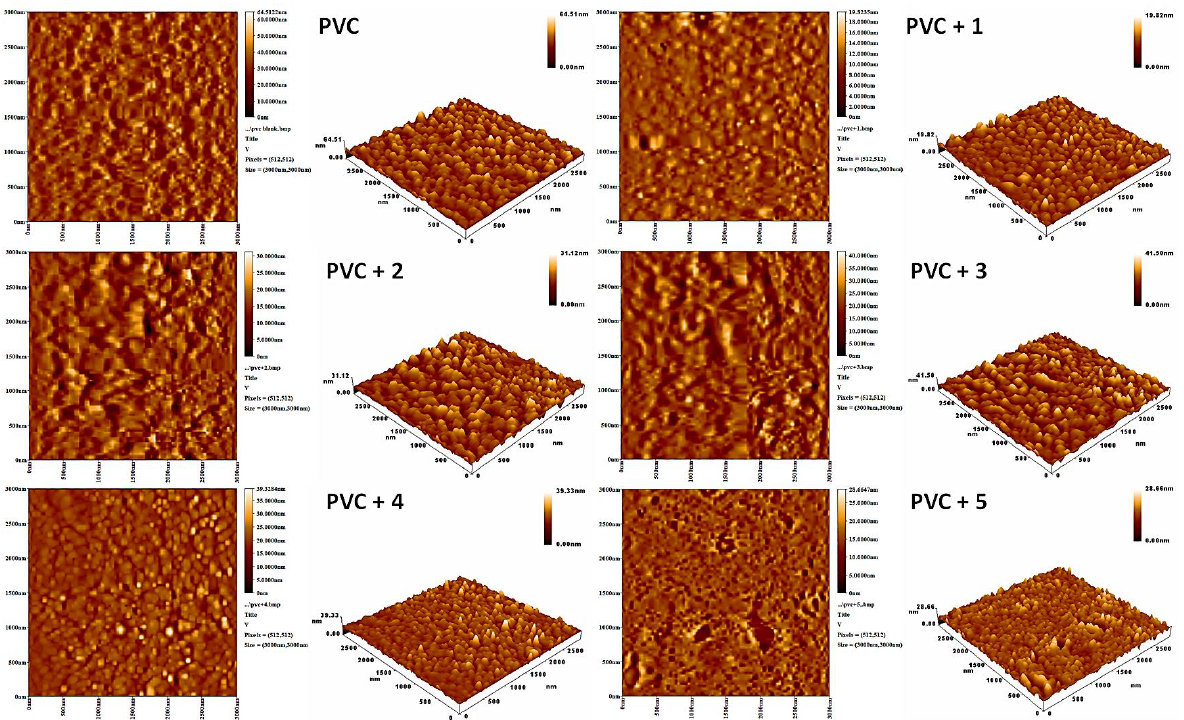
Figure 11. AFM images of the irradiated PVC